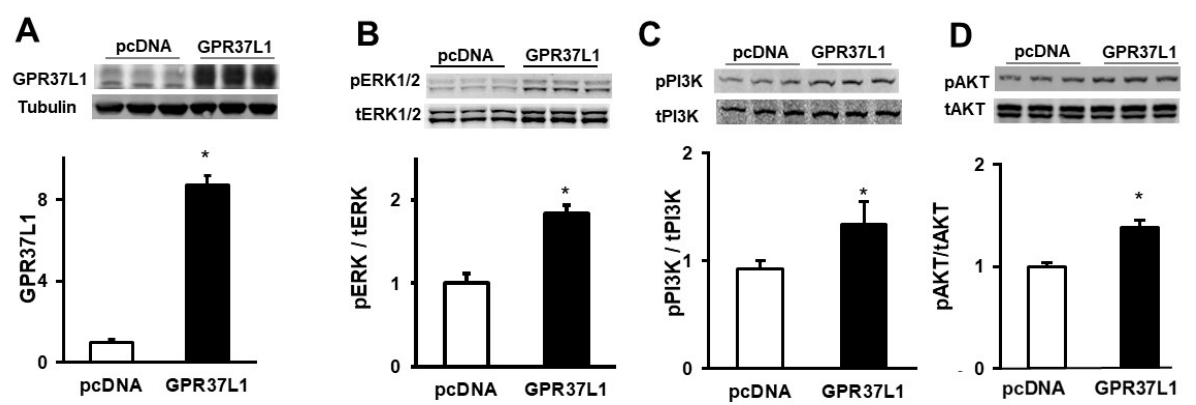
Figure 7. GPR37L1 activates PI3/AKT/mTOR signaling. PI3K/AKT/mTOR signaling components in hRPTCs expressing GPR37L1 were probed by immunoblotting. The hRPTCs were transfected with GPR37L1 (GPR37L1) or control plasmid (pcDNA). ( A ) Immunoblots of GPR37L1 in hRPTCs transfected with pGPR37L1. ( B – D ) Quantification of phospho-ERK1/2,(p-ERK1/2), phospho-PI3K (pPI3K), and phospho-AKT (S473) (pAKT) was normalized to the corresponding total (t) protein. n